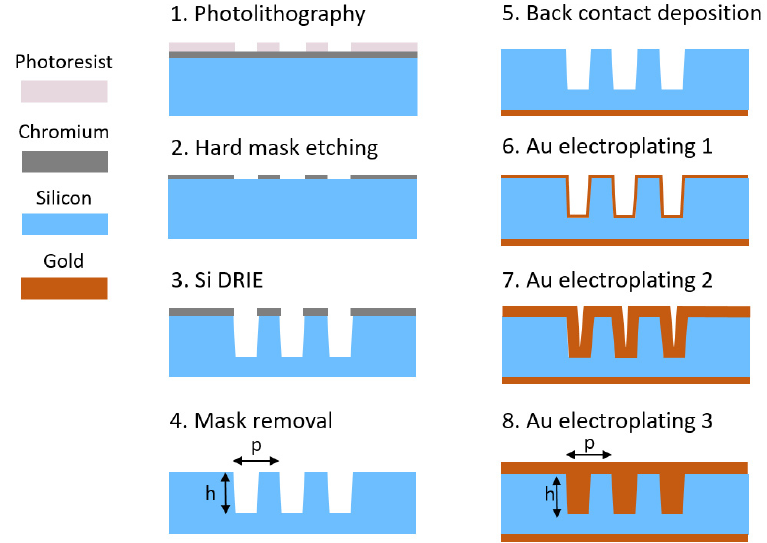
Figure 1. Fabrication steps. Steps 1–4: fabrication of high aspect ratio Si structures with a pitch p and a height h and a tapered profile. Step 5: deposition of the ohmic Au contact on the back side of the wafer. Step 6: seedless formation of the initial Au layer directly on the surface of the grating. Step 7: intermediate stage of Si trench filling by Au. Step 8: complete filling of Si trenches with Au.